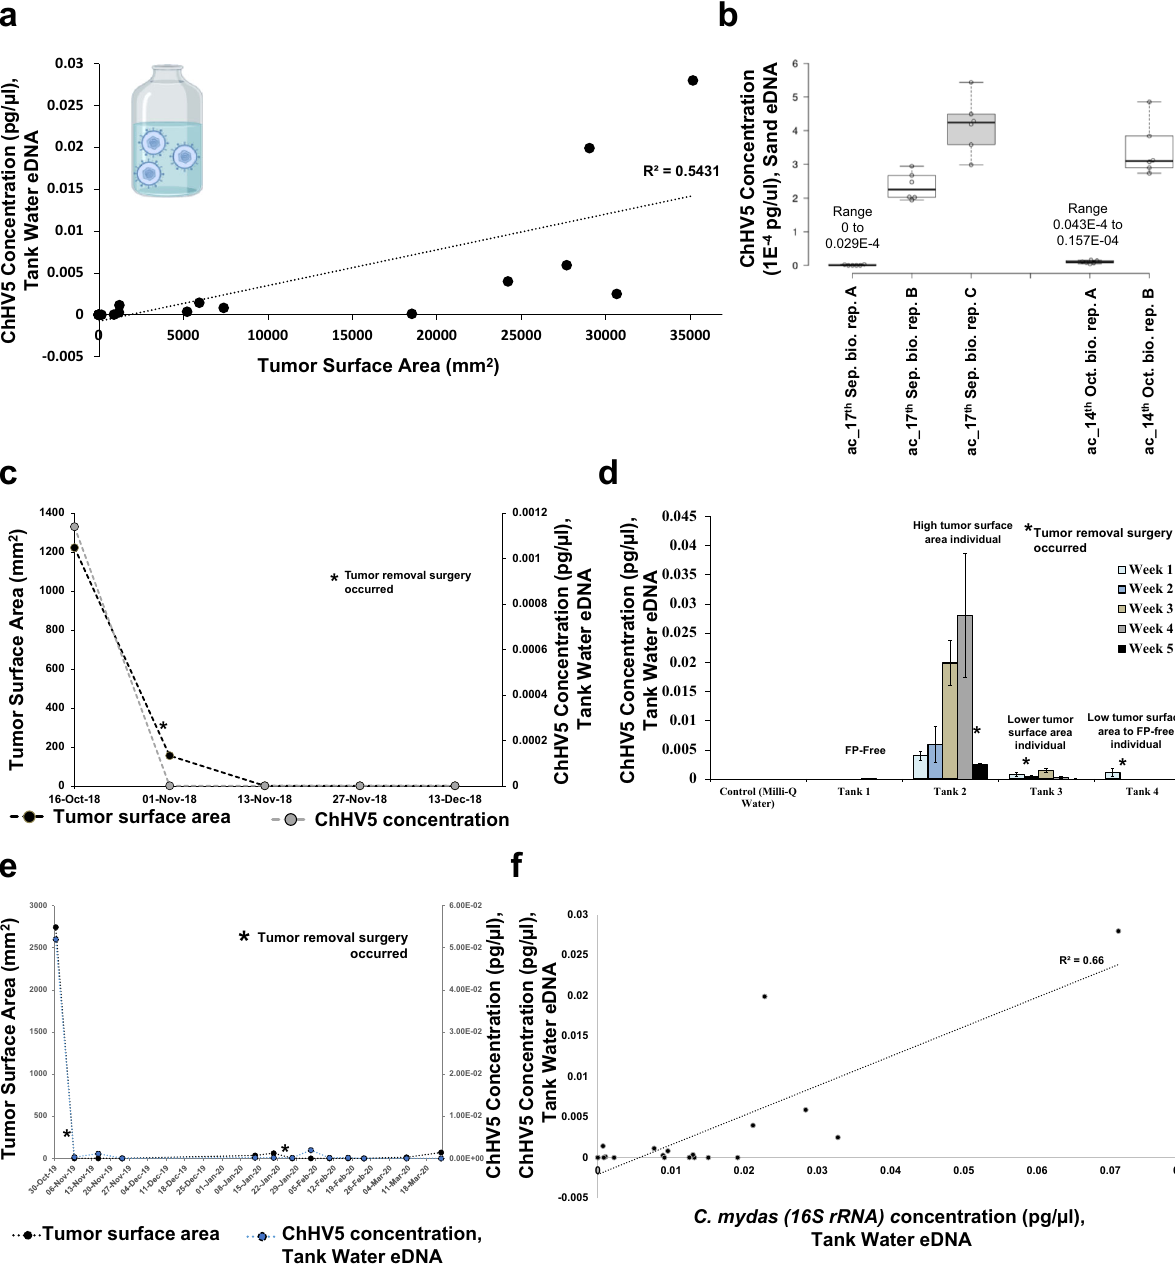
COMMUNICATIONS BIOLOGY| (2021) 4:565